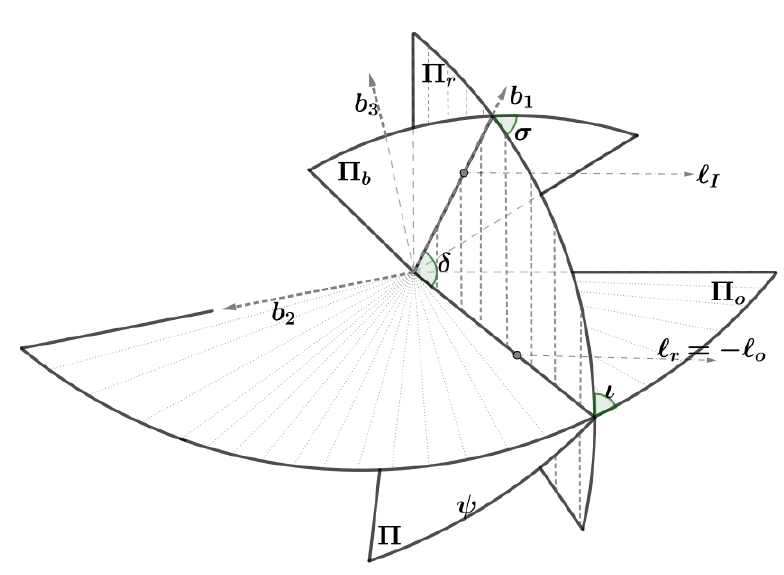
Fig. 9 Special relative equilibria of the body-perpendicular type with ν = ± n π .